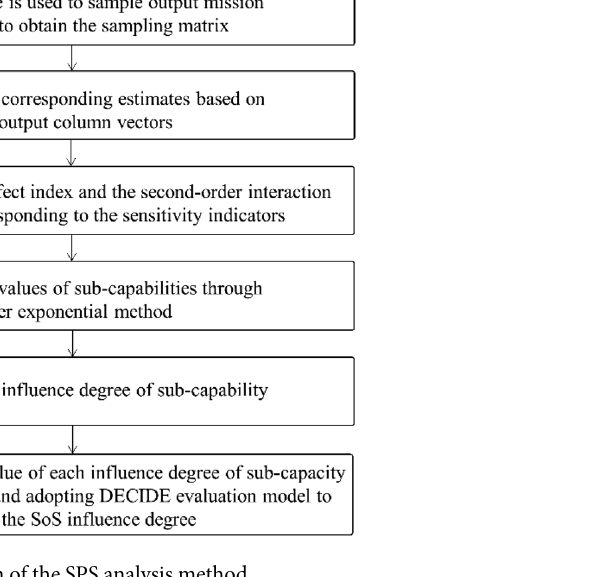
individual parameter and functions of the combinations between parameters, and analyzes the importance of parameters and the interaction effects between parameters by calculating the influence of the variance of indi- vidual input parameter or input parameter sets on the total output variance. The key steps are shown in Fig. 2.